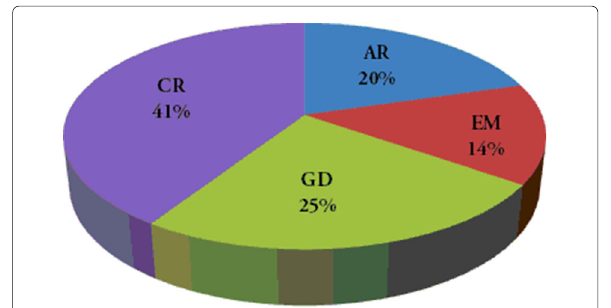
41%. After introducing negotiation the total service- able option increased to 74% (41% Replaceable + 34%